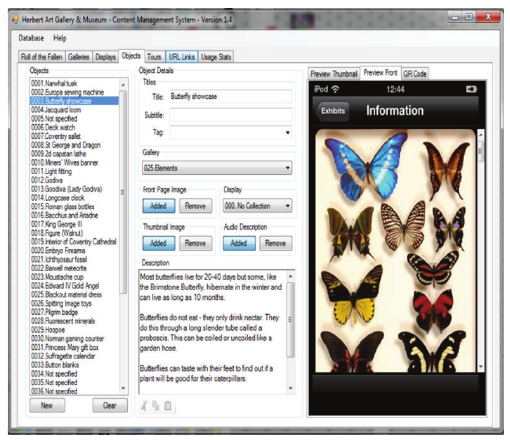
Figure 7: The gallery content management